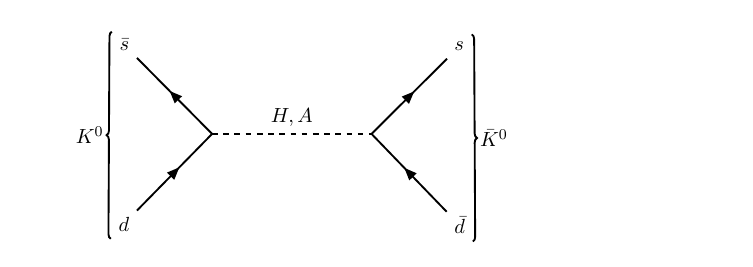
Figure 7 . Contour plot in the tan β vs M H plane showing the allowed parameter space by the experimental measurement of K 0 − ¯ K 0 mixing. The region shaded in red gives a larger contribution than the measured value of ∆ m EXP . For the left (right) panel we fix the mixing angles to sin θ = √ K sin θ = 1 / 2 ( sin θ = sin θ = 0 . 1 ). c c